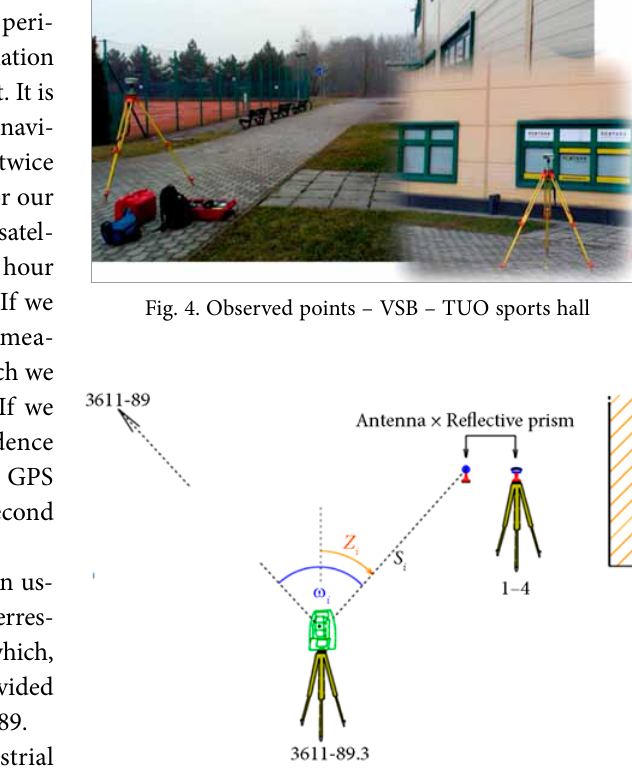
Fig. 5. Terrestrial measurement of the